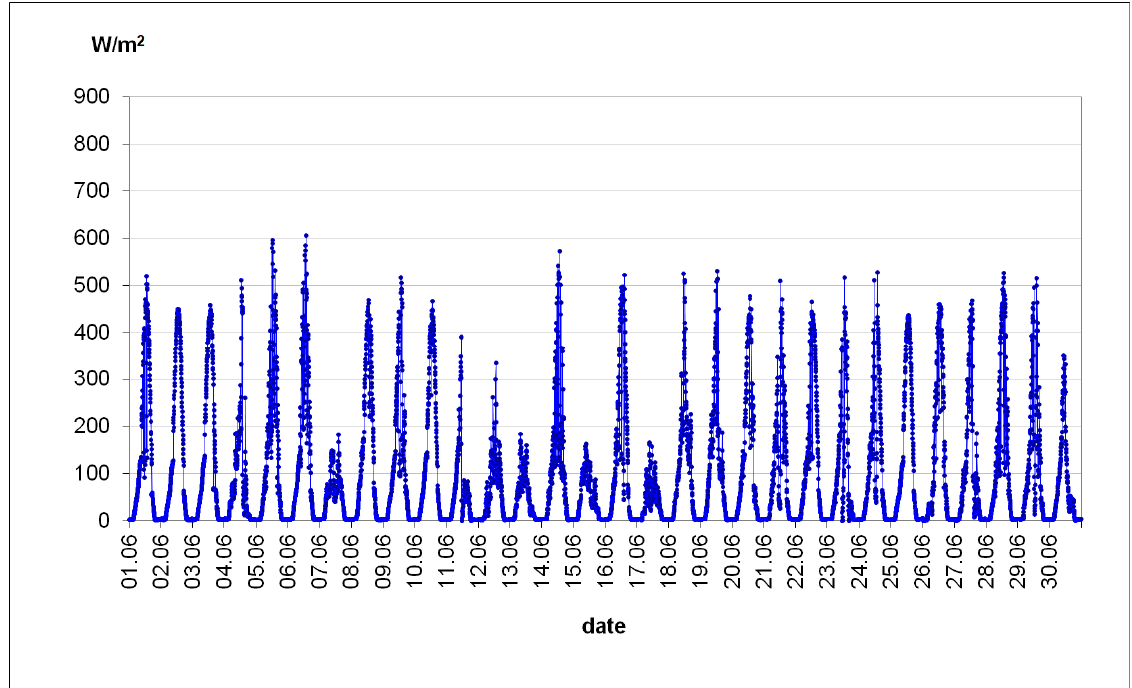
Figure 11. Graph of the global solar irradiance incident on the southern vertical plane in June.